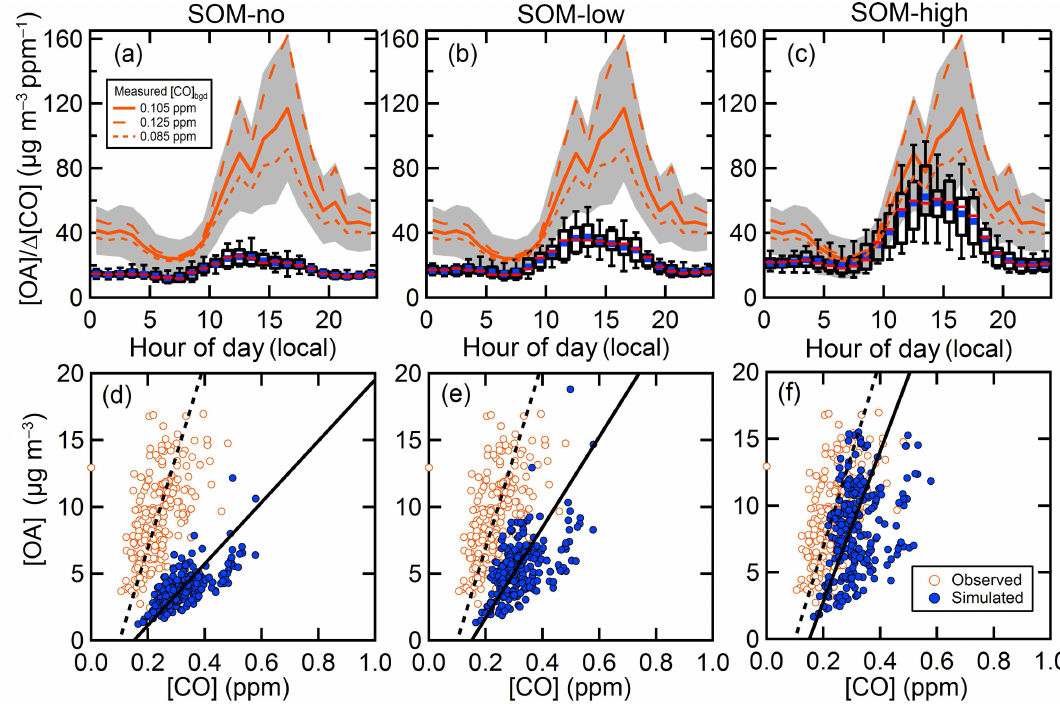
Figure 5. Simulated and observed diurnal profiles for the OA /(cid:49) CO ratio (top panels) at Riverside, CA, during the SOAR-2005 campaign for (a) SOM-no, (b) SOM-low and (c) SOM-high simulations. For the observations, the mean (solid orange line) and the 1 σ variability range (grey band) are shown for [CO] bgd = 0.105ppm, and only mean values are shown for [CO] bgd = 0.085ppm (short dashed orange line) and [CO] bgd = 0.125ppm (long dashed orange line). For the simulations, box and whisker plots are shown with the median (red –), mean (blue squares), lower and upper quartile (boxes), and 9th and 91st percentile (whiskers). The bottom panels (e–f) show scatter plots of [OA] vs. [CO] for both the ambient measurements (open orange circles) and for the model results (blue circles) for daytime hours (10:00–20:00LT). The lines are linear fits where the x axis intercept has been constrained to go through the assumed [CO] bgd (dashed = observed; solid = model). The derived slopes are 69 ± 2 (observed), 23.0 ± 0.4 (SOM-no), 34.0 ± 0.8 (SOM-low) and 55 ± 2 (SOM-high) µgm − 3 ppm − 1 and where the uncertainties are fit